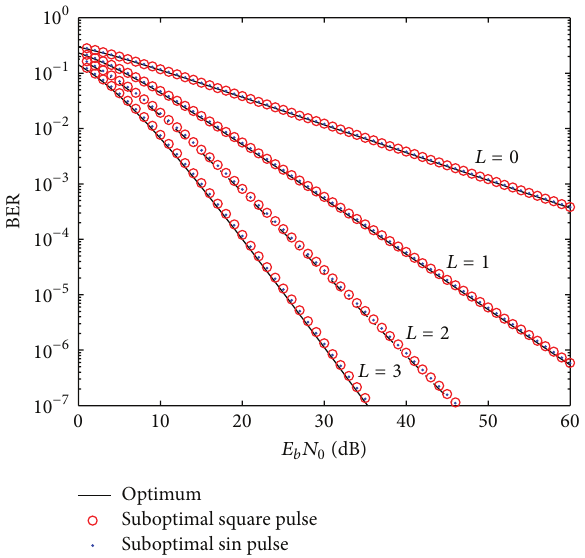
Figure 3: BER performance comparison of cooperative EC-BPPM modulation in Nakagami- m channel for the eighth order of the Gaussian pulse with optimal and suboptimal square